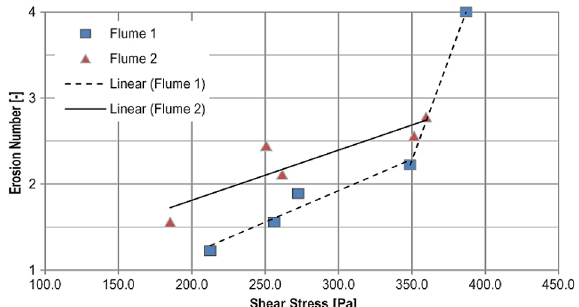
Fig. 15. Erosion numbers flumes 1 & 2 (unvegetated); steep trend line = high erosion rate, September